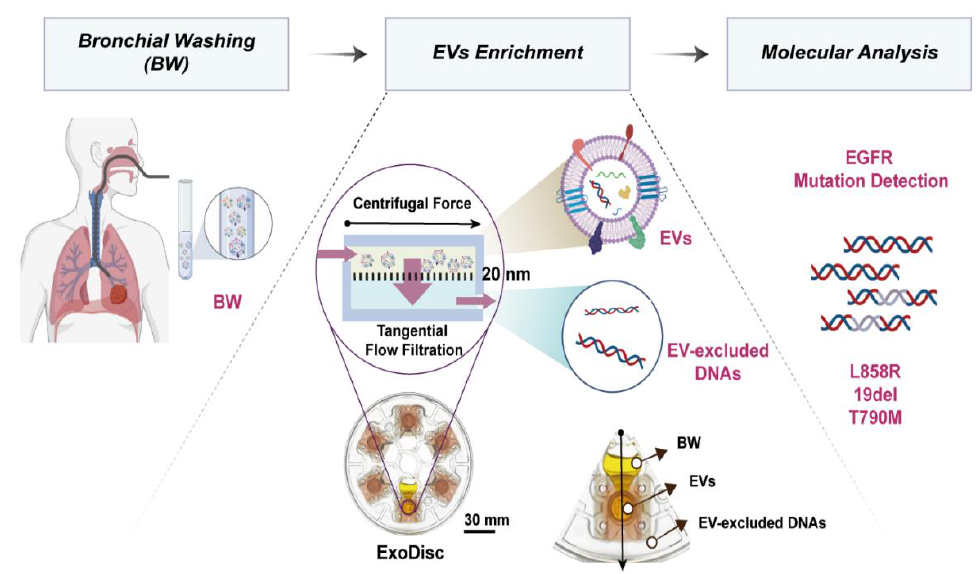
Figure 1. Schematic illustration of experimental process. Bronchial washing (BW) samples are injected into an Exo-Disc. Upon spinning the disc, the liquid flow through the filter that is in tangential direction with the centrifugal force minimizing the clogging issue. The extracellular vesicles (EVs) are enriched on top of the filter by size-based isolation and the flow-through liquid is used to analyze the EV-excluded cell free DNA. The EGFR mutation is confirmed by Polymerase Chain Reaction.